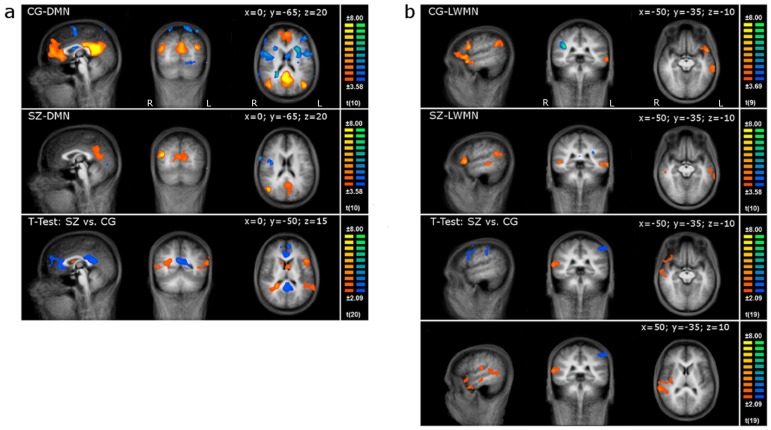
RSNs of healthy controls and patients.The first 2 rows depict the sagittal, coronal, and horizontal slices of the DMN (1a) and LWMN (1b) in the control (CG) and patient group (SZ; p<0.005; corrected at α<0.05; x, y, & z Talairach coordinates are given at the top right corner of each RSN, T-values are indicated at the right side of each analysis). The third and fourth lines display the t-test results between patients and controls (p<0.05, corrected at α<0.05; x, y, & z coordinates are given at the top right corner of each RSN, for the LWMN two additional slices are presented; T-values are indicated at the right side of each analysis). L: left; R: right.